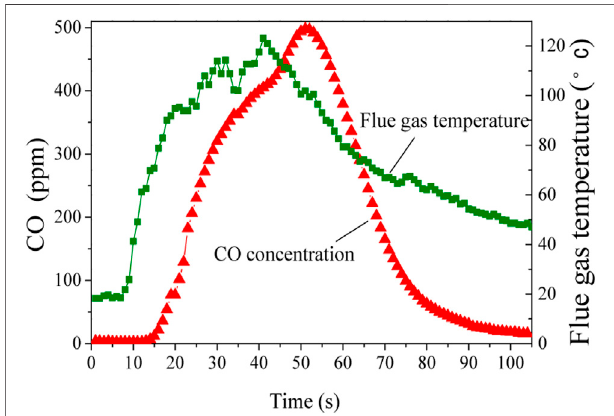
FIGURE 2 | CO concentration and fl ue gas temperature of